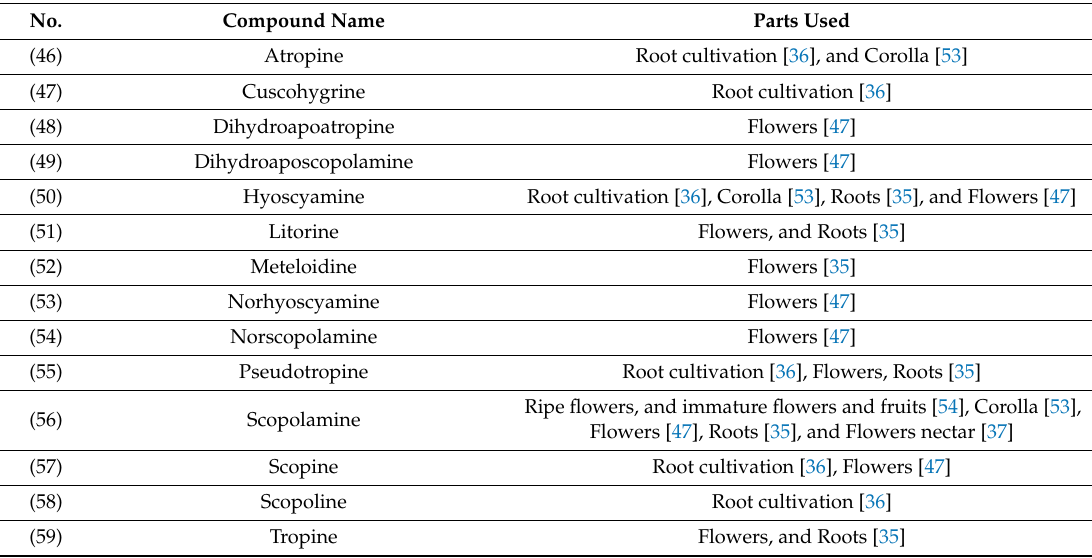
Table 3. Volatile Compounds from Brugmansia suaveolens.